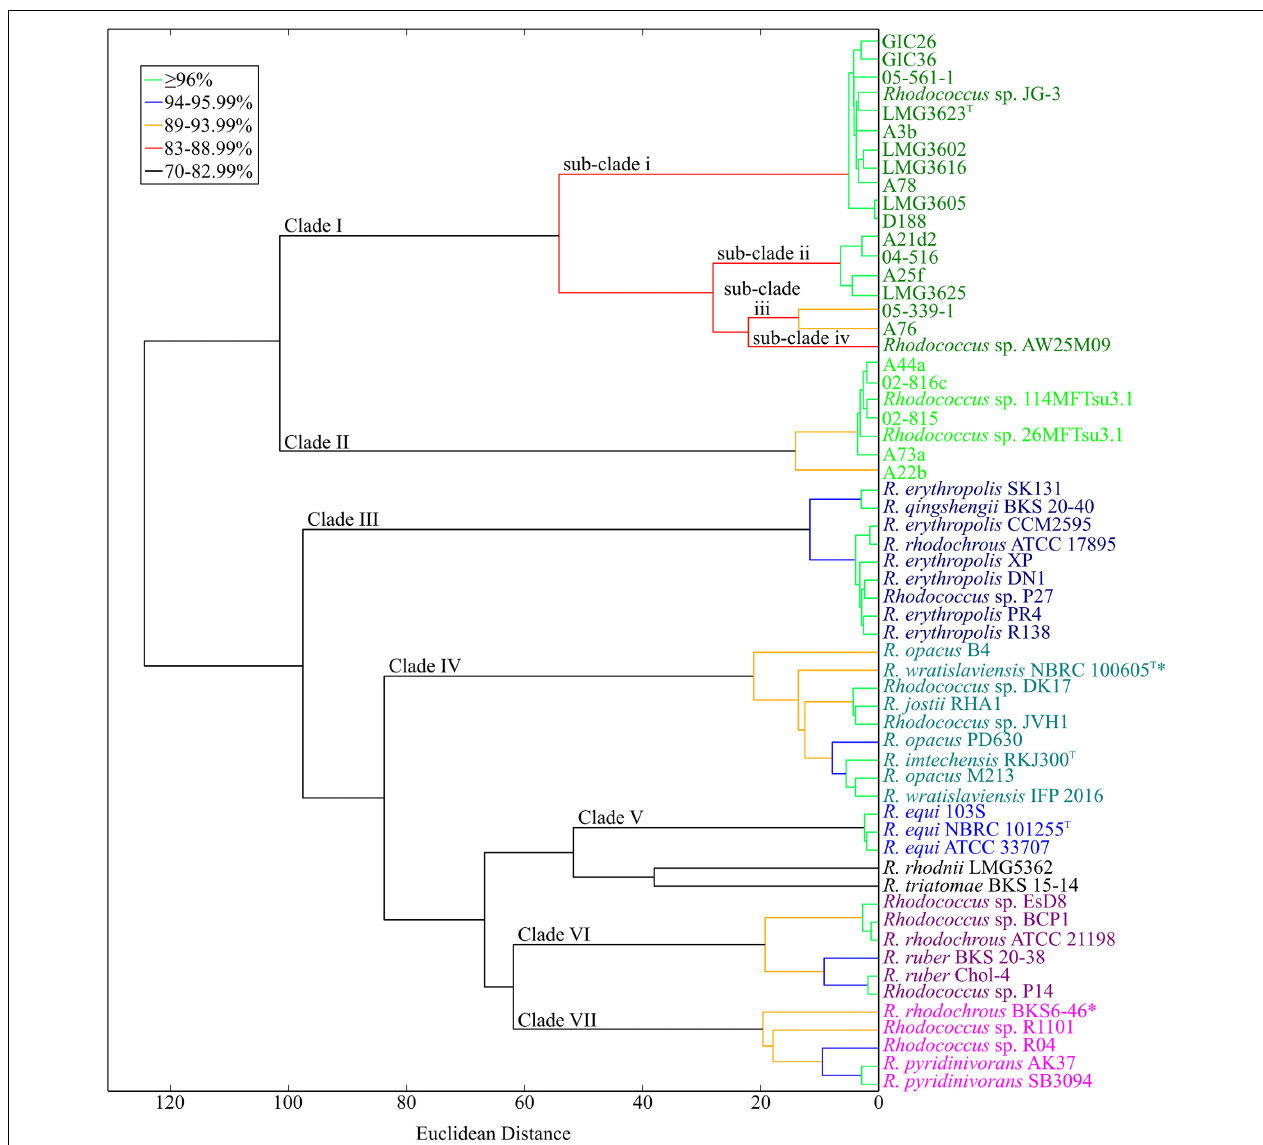
FIGURE 5 | Average nucleotide identity dendogram for 59 isolates of Rhodococcus . Complete genome sequences for 59 isolates of Rhodococcus were used to generate an ANI matrix. The matrix was used to calculate an ANI divergence dendrogram. Groups are color coded according to groups represented in the MLSA ML tree. Branches are colored using cutoffs for pairwise comparisons of all taxa after the